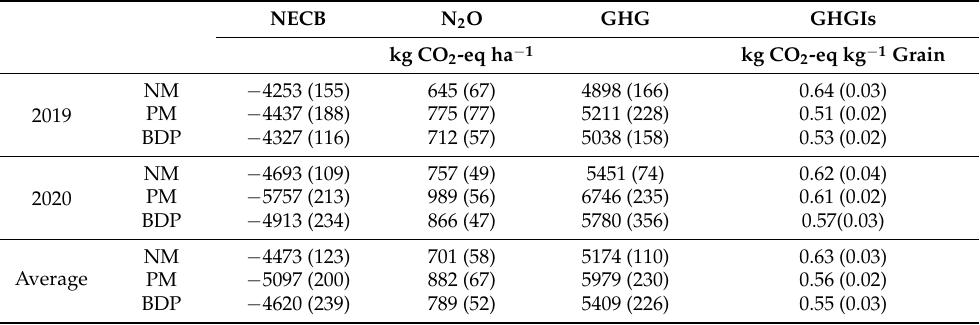
Table 1. Characteristics of net ecosystem carbon budget (NECB), greenhouse gas emissions (GHG), and greenhouse gas intensity (GHGIs) in no mulch, PE mulch (PM) and biodegradable plastic mulch (BDP) at growing stage.